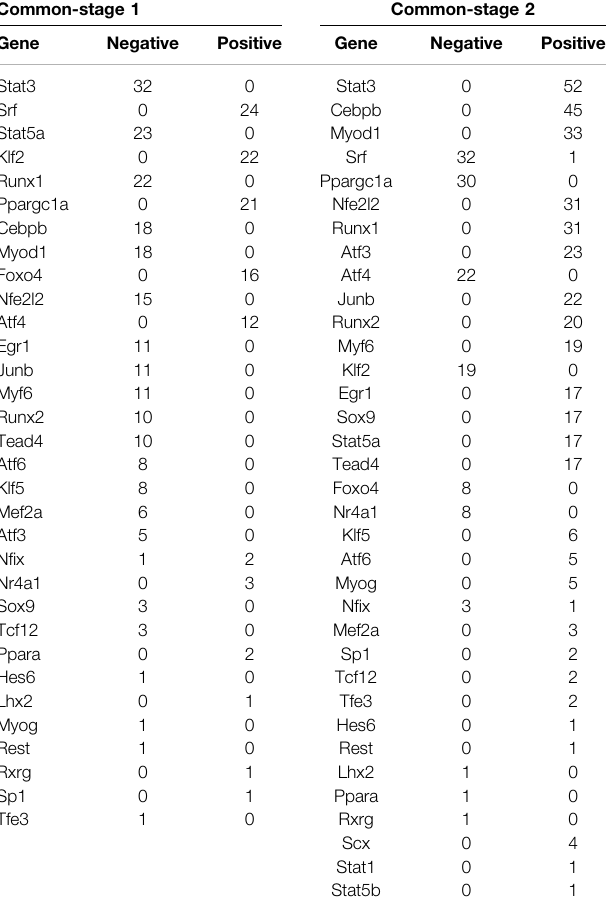
TABLE 1 | Correlation between differentially expressed TFs and their targetgenes in common-stage1 and common-stage2. Common-stage